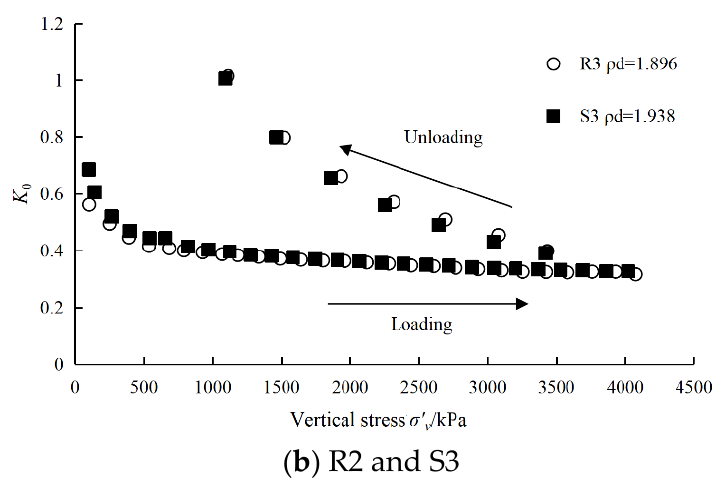
Figure 8. K 0 behavior of sandy gravel and rockfill under loading and unloading conditions. To further study the effect of the coarse-grained soil type on K 0 , the average values of K 0 under different σ (cid:48) v values of R2, S3, R3, and S4 were listed in Table 5. According to Table 5, under the same conditions of initial relative density and gradation, the K 0 of sand gravel is over 10% larger than that of rockfill. Under the unloaded condition, the K 0 of sand gravel is over 14% larger than that of rockfill. From the above results, the soil type has a certain influence on the coarse-grained soil, and the K 0 of sand gravel is larger than that of rockfill under the same initial conditions. Moreover, the influence of soil type on coarse-grained soil needs to be further studied. Table 5. The average value of K 0 during loading/unloading for test specimens. Sand and